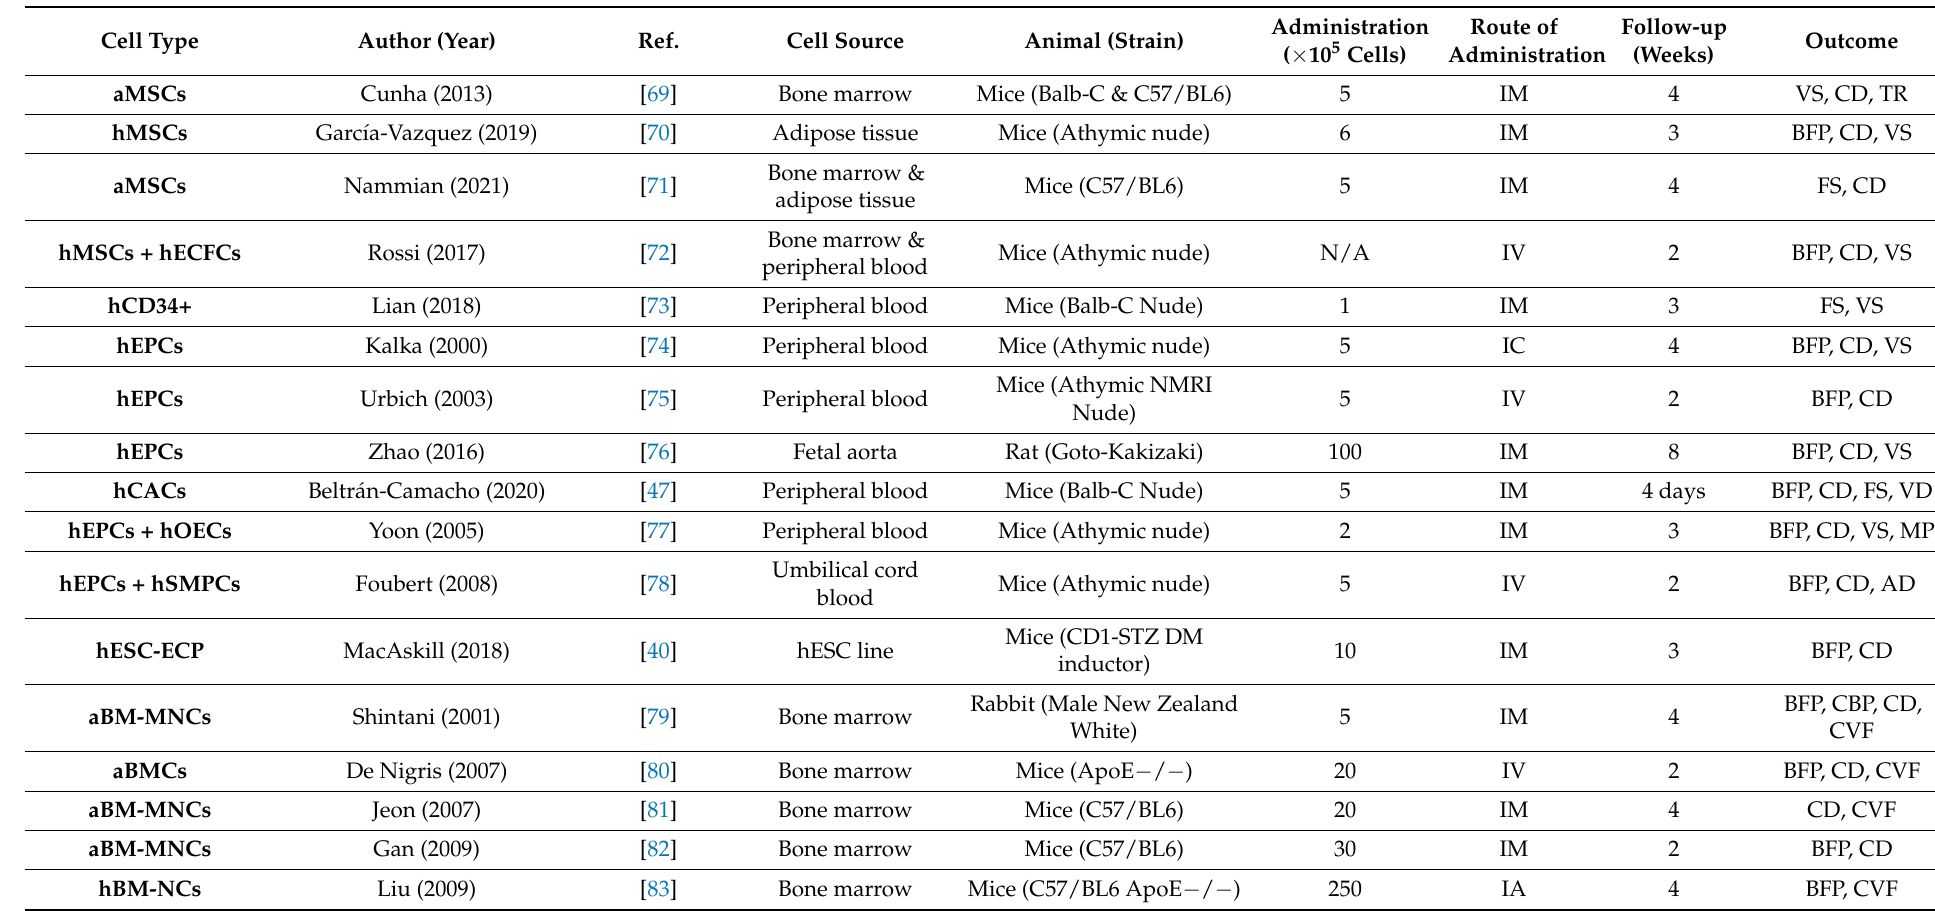
Table 1. Classification of most important cell therapy pre-clinical studies. The table includes cell type used, first author and year of publication, reference number (ref), cell source, animal and strain, number of administered cells, route of administration, follow-up, and parameters checked to evaluate the therapy outcome. Abbreviations included (alphabetical order): a: autologous; AD: Arteriolar density; AI: Angiographic index; BFP: Blood flow perfusion; CBP: Calf Blood Pressure; CD: Capillary density; CVF: Collateral Vessel Formation; ESC-ECP: Stem cell-derived endothelial cell product; FS: Functional score; h: human; IA: Intraarterial; IC: Intracardiac; IM: Intramuscular; IV: Intravenous; MP: Matrigel plug; SC: Subcutaneous; TR: Tissue regeneration; VD: Vessel diameter; VIP: Vascular intersection percentage; VS: Visual